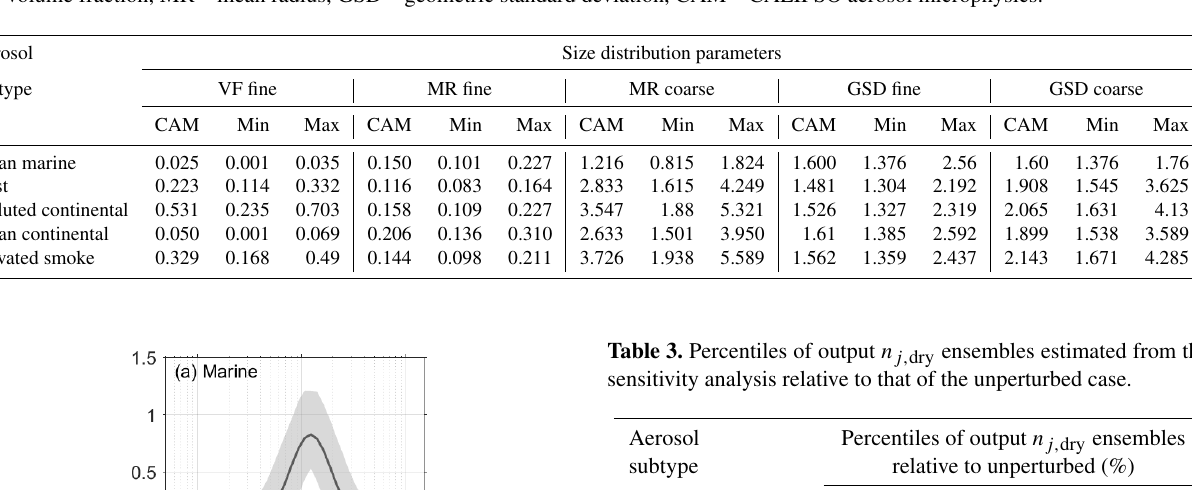
Table 2. Bimodal log-normal volume size distribution parameters along with their limits considered in the sensitivity analysis. Abbreviations: VF – volume fraction, MR – mean radius, GSD – geometric standard deviation, CAM – CALIPSO aerosol microphysics.